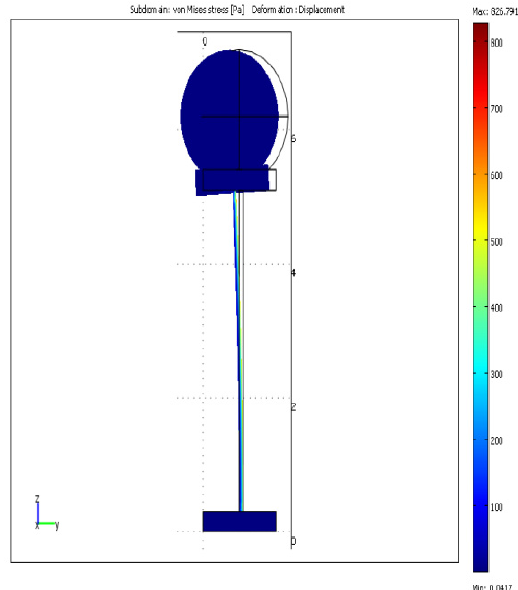
Figure 6. Von Mises stress distribution plot of